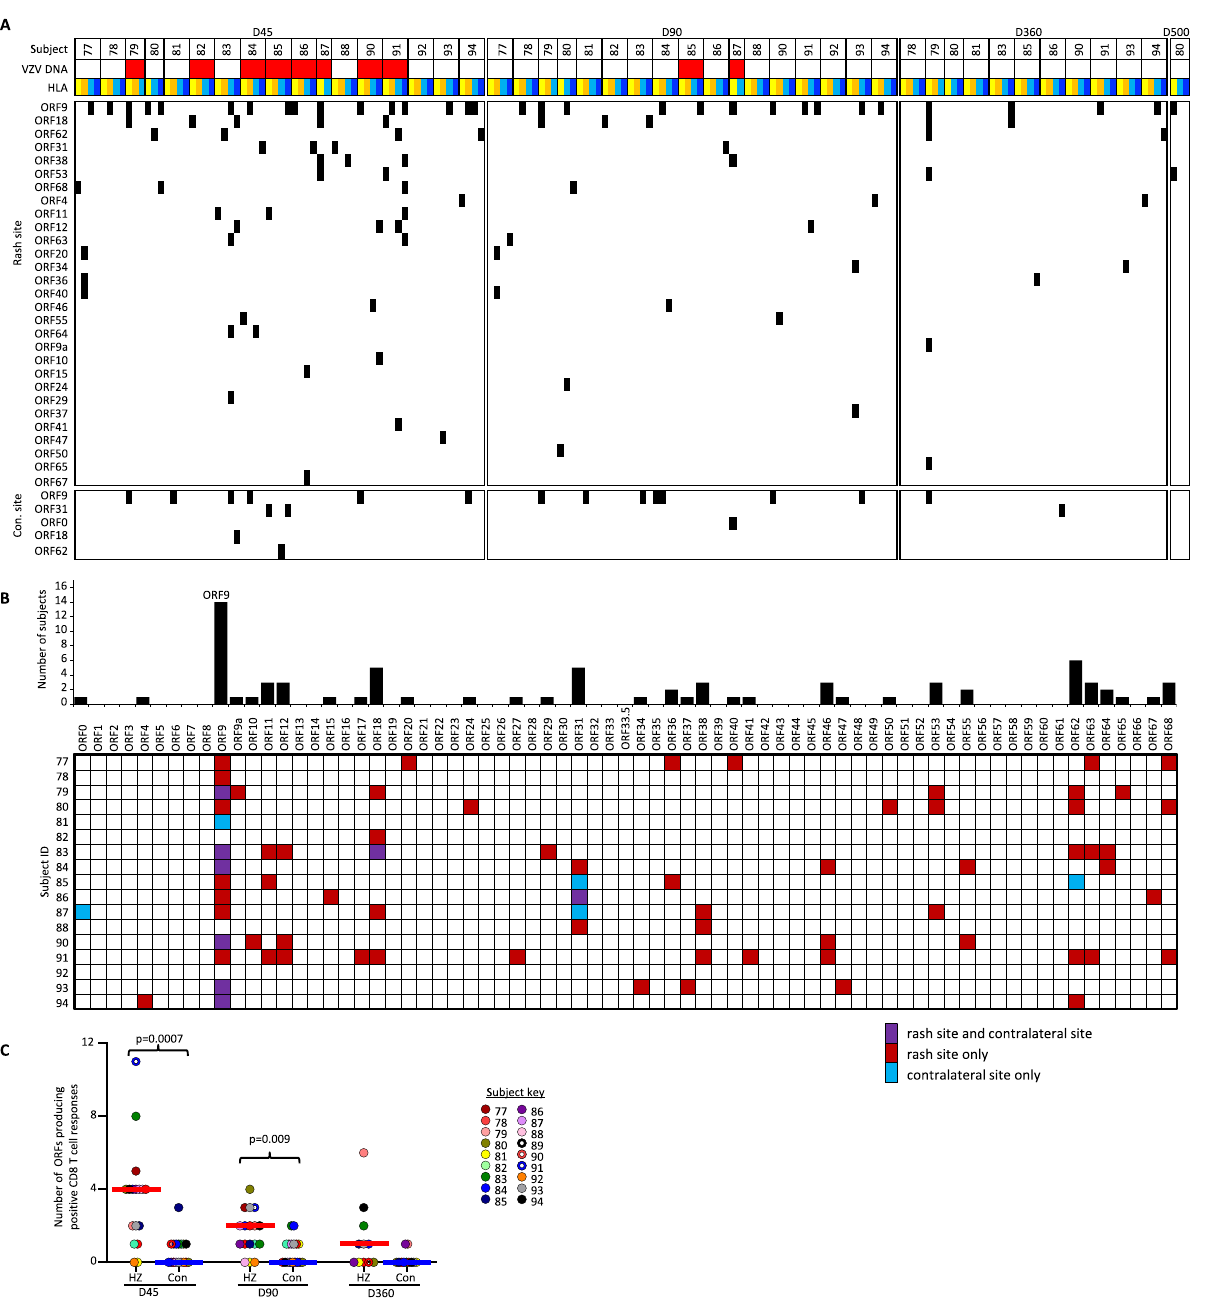
Fig. 4 | VZV-speci fi c skin CD8 T cells. Skin-TCL containing a mixture of CD4 and